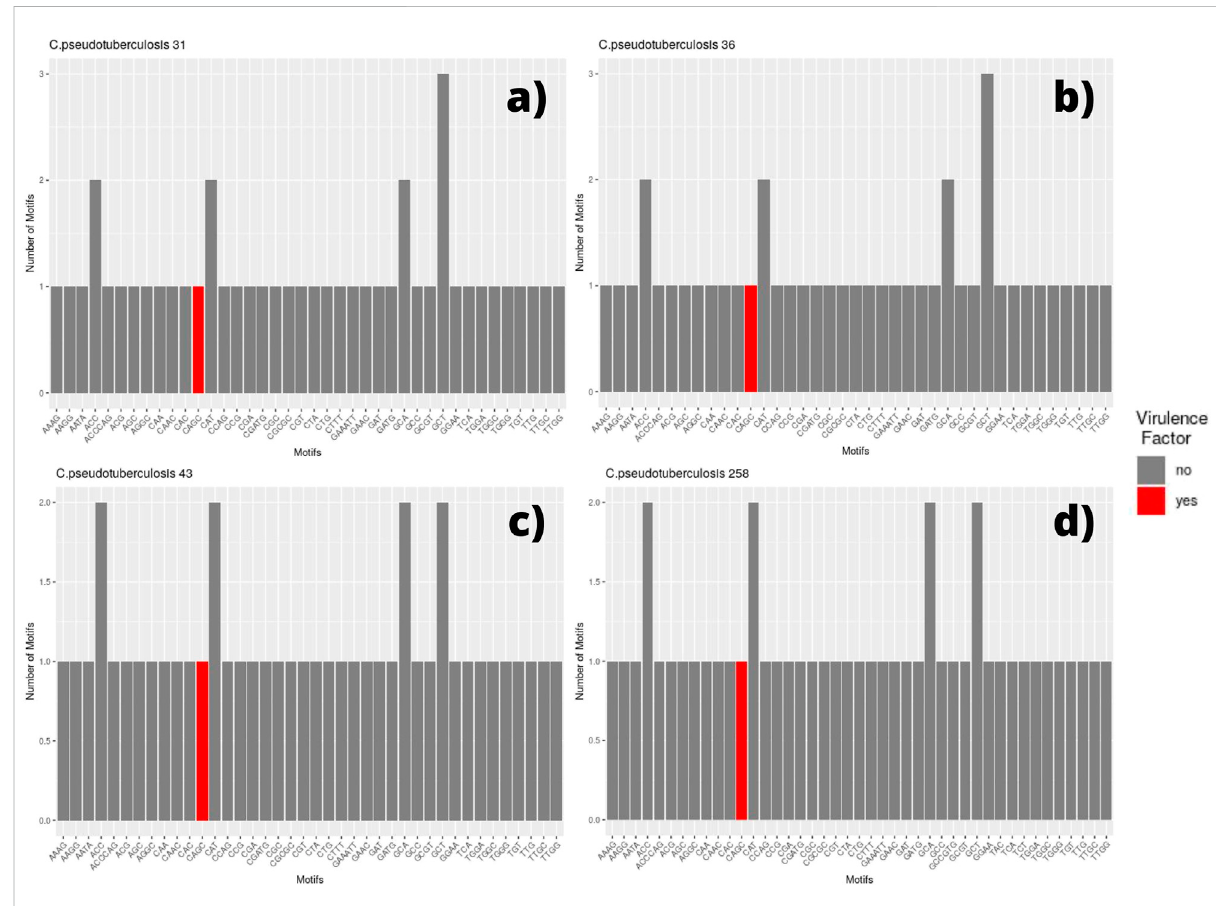
FIGURE 2 BargraphshowingthenumberofdifferentSSRmotifsobservedin Corynebacteriumpseudotuberculosis strains.Inorder,strain31 (A) ;strain36, withremarkstotheabsenceoftheCGTmotifinthisgenome (B) ;strain43,withremarkstotheGCTmotifoccurringtwiceinthisgenomeindifferent regions (C) ; and strain 258, presenting the same pattern that can be observed in C. pseudotuberculosis CIP 52.97 (D)